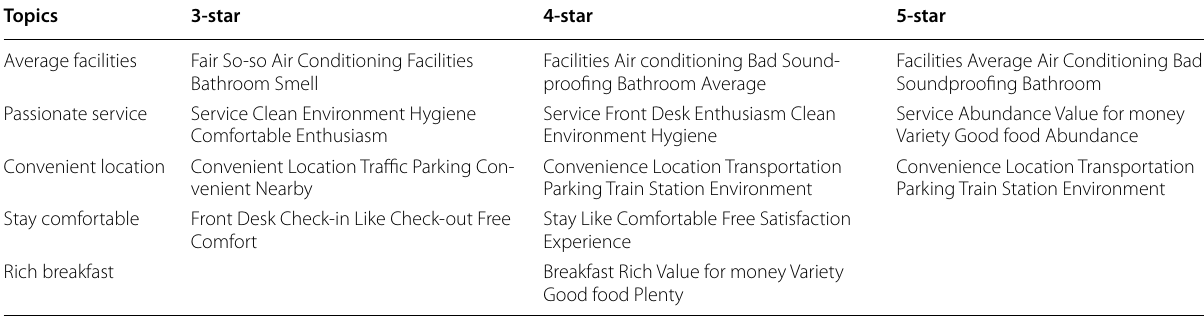
Table 6 LDA topic model results